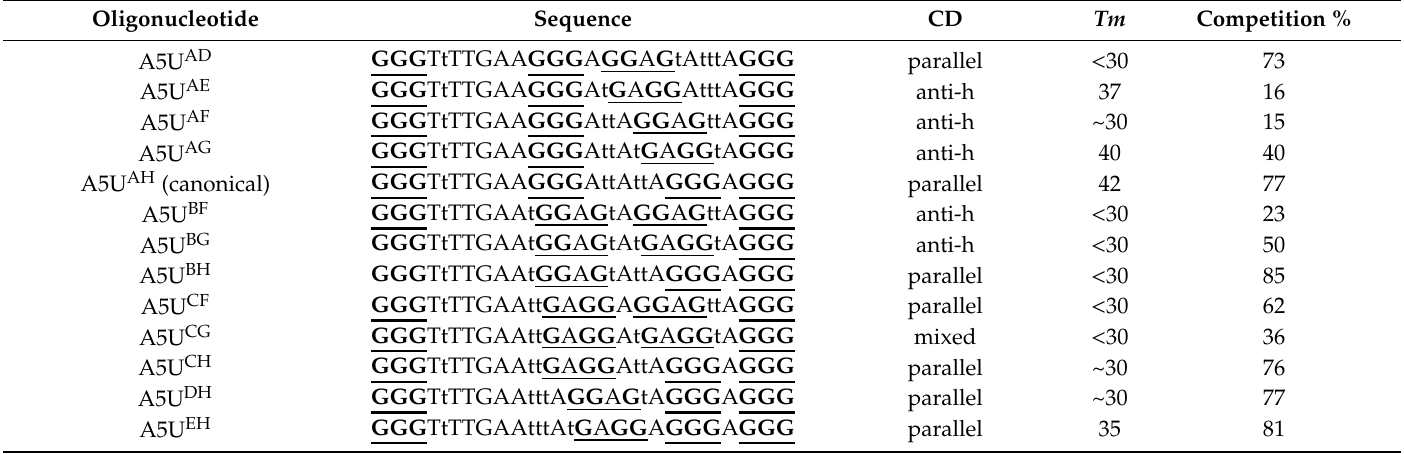
Table 1. Summary of the properties of trim_A5U-locked variants. Gs that participate in G4 formation are in bold and G-tracts are underlined and bold. Mutated residues are in